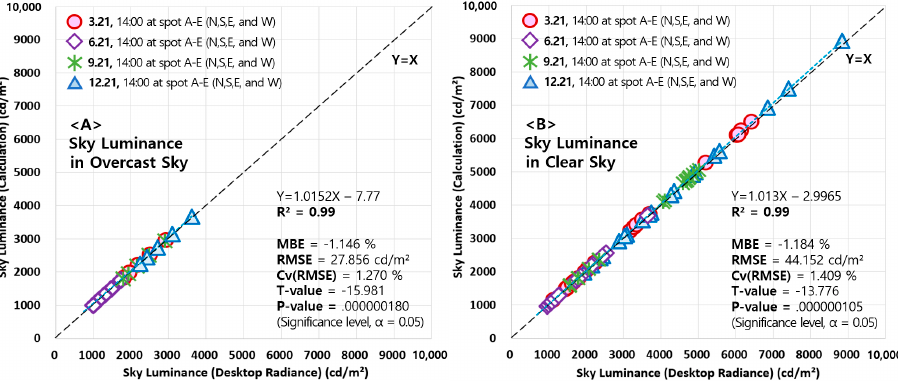
Figure 10. Comparison of sky luminance between the CIE sky algorithm and Desktop Radiance. ( A ) Overcast sky ( B ) Clear sky.